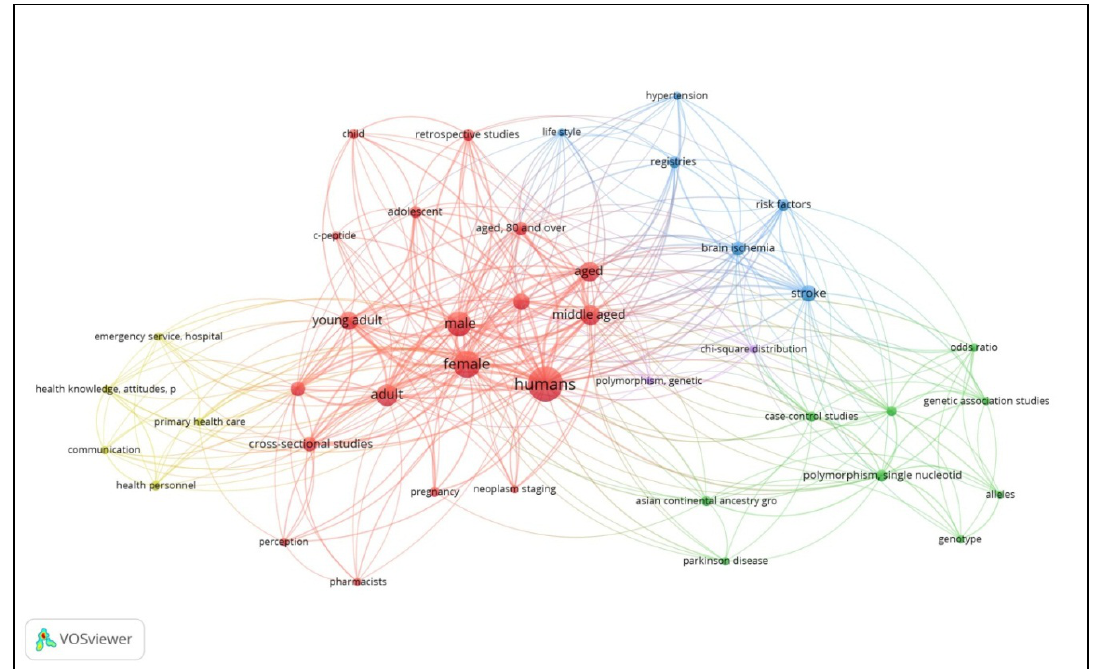
Figure 3. Network visualization map of co-occurrence of MeSH keywords. Keywords with minimum occurrence of two times are shown in the map. Keywords shown with the same colour are closely related and listed together. Size of the nodes and words represent weights; the bigger the nodes and words, the larger the weights. Distance between two nodes reflects the strengths between them; a shorter distance means stronger relations. The line between two keywords means they appeared together; the thicker the line, the higher the